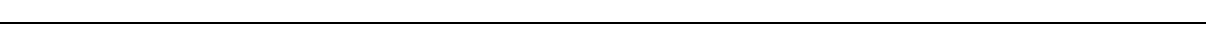
Fig. 1 SyCyRs for IL-23 (SyCyR(IL-23/2A)) simulate IL-23-induced signal transduction. a Schematic illustration of IL-23 SyCyR and GFP-mCherry fusion protein. G VHH -IL-12R β 1: G VHH fused to 15 aa of the ECD, TMD, and ICD of IL-12R β 1. C VHH -IL-23R: C VHH fused to 17 aa of ECD, TMD, and ICD of IL-23R. b Proliferation of Ba/F3-gp130 cell lines with HIL-6 and GFP:mCherry cultured with synthetic ligands (6.25 ng/ml) or HIL-6 (10 ng/ml). Stimulation with mCherry was made with the same volume as with GFP (0.25%). One representative experiment out of three is shown. c Proliferation of Ba/F3-SyCyR(IL- 23/2A) and Ba/F3-gp130 cells with GFP-mCherry and Ba/F3-IL-12R β 1-IL-23R cells with HIL-23 cultured in the presence of ligands (0.1 to 1600 ng/ml). One representative experiment out of fi ve is shown. d Proliferation of Ba/F3-SyCyR(IL-23/2A) and Ba/F3-gp130 cells with GFP-mCherry fusion protein in